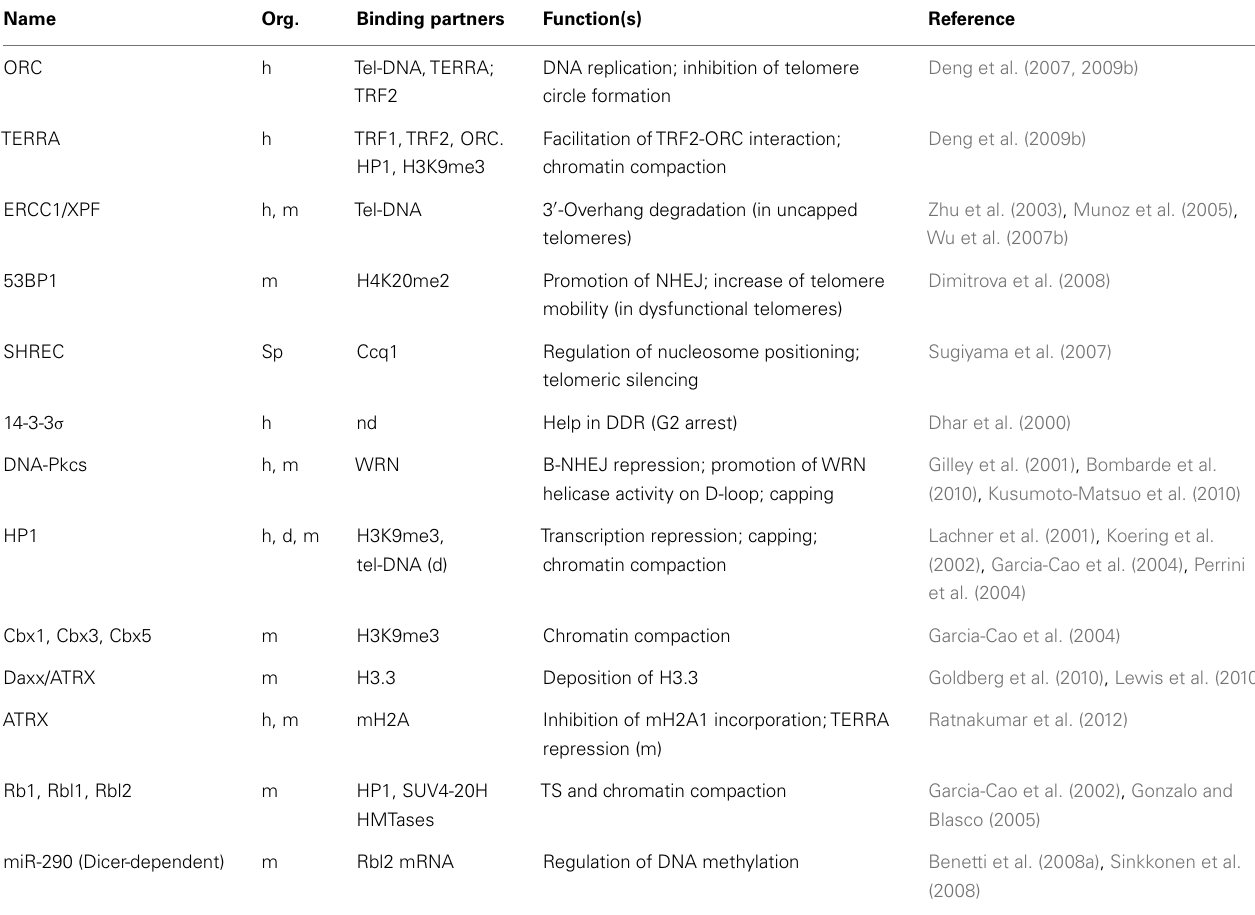
Table 3 | Factors influencing telomeric